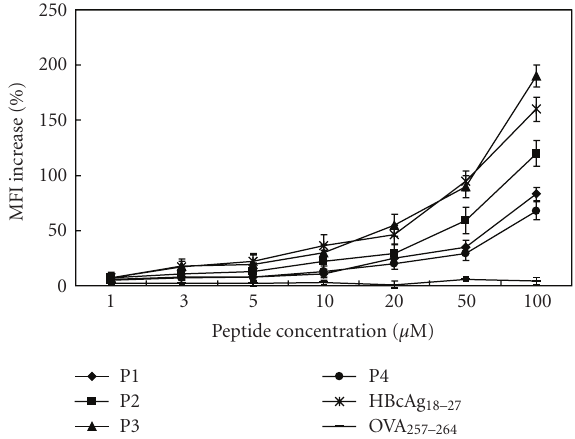
Figure 1: Binding a ffi nity of peptides for HLA-A ∗ 0201 molecule. T2 cells were incubated with indicated concentrations of the peptides in serum-free RPMI 1640 medium supplied with 3 μ g/mL human β 2m at 37 ◦ C for 16h. And then the cells were stained with anti-HLA-A2 mAb and FITC-labeled goat antimouse IgG. The expression of HLA-A ∗ 0201 on T2 cells was determined with FACS Calibur flow cytometer. The peptides HBcAg 18–27 and OVA 257–264 were taken as positive control and negative control, respectively. Each sample was measured in three replicates and the experiment was repeated three